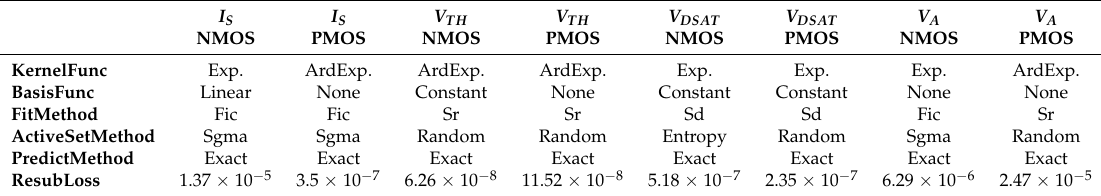
Table 1. Optimal options of the function fitrpg for the training of the Gaussian Process (GP) model from the characterization of the process parameters in typical corner. I S I S V TH NMOS PMOS NMOS KernelFunc